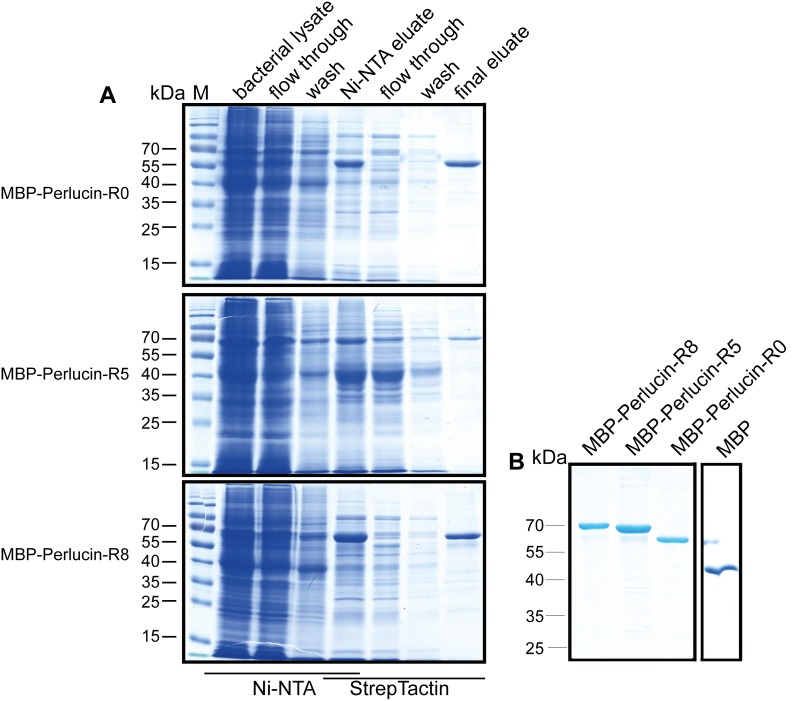
Purification of Perlucin splice variants fused with MBP.Recombinant proteins were expressed in E. coli Rosetta (DE3) pLacI and purified via N-terminal His-tag and C-terminal Strep-tag of MBP-Perlucin-R0 (60kDa), MBP-Perlucin-R5 (68kDa) and MBP-Perlucin-R8 (72kDa) and MBP (42kDa) as described in the Methods section. (A) Samples representing the purification steps. (B) Purified proteins after dialysis.